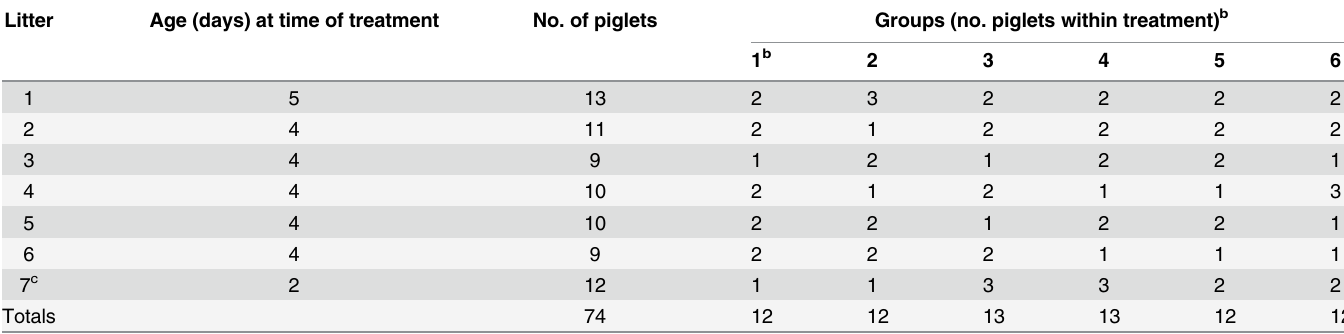
Table 1. Allocation of piglets to treatments by litter a .